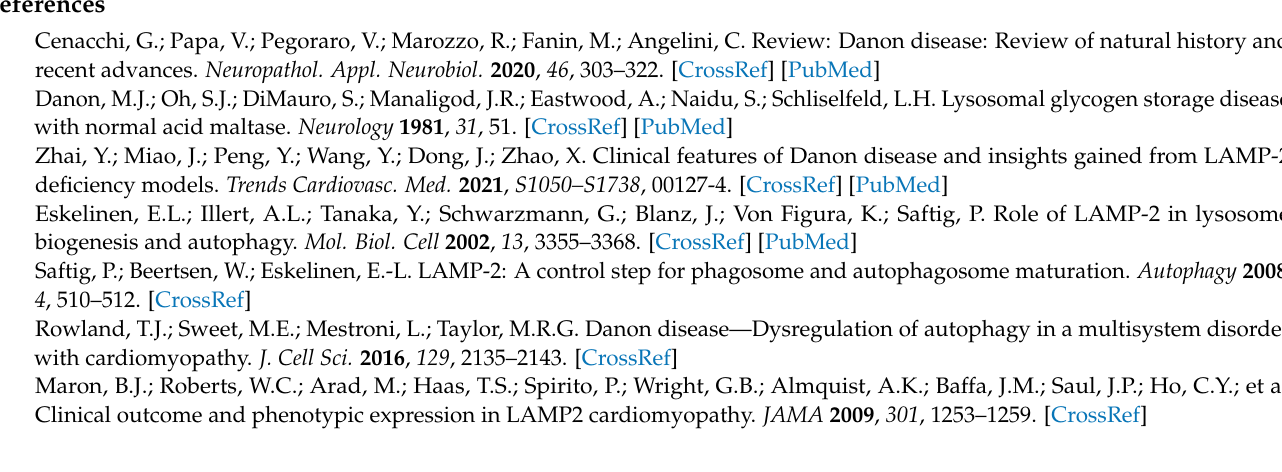
Table S2: Summary of the information of antibodies used in the current study. Table S3: Summary of the sequences of sgRNA off-target genotyping primers used in the current